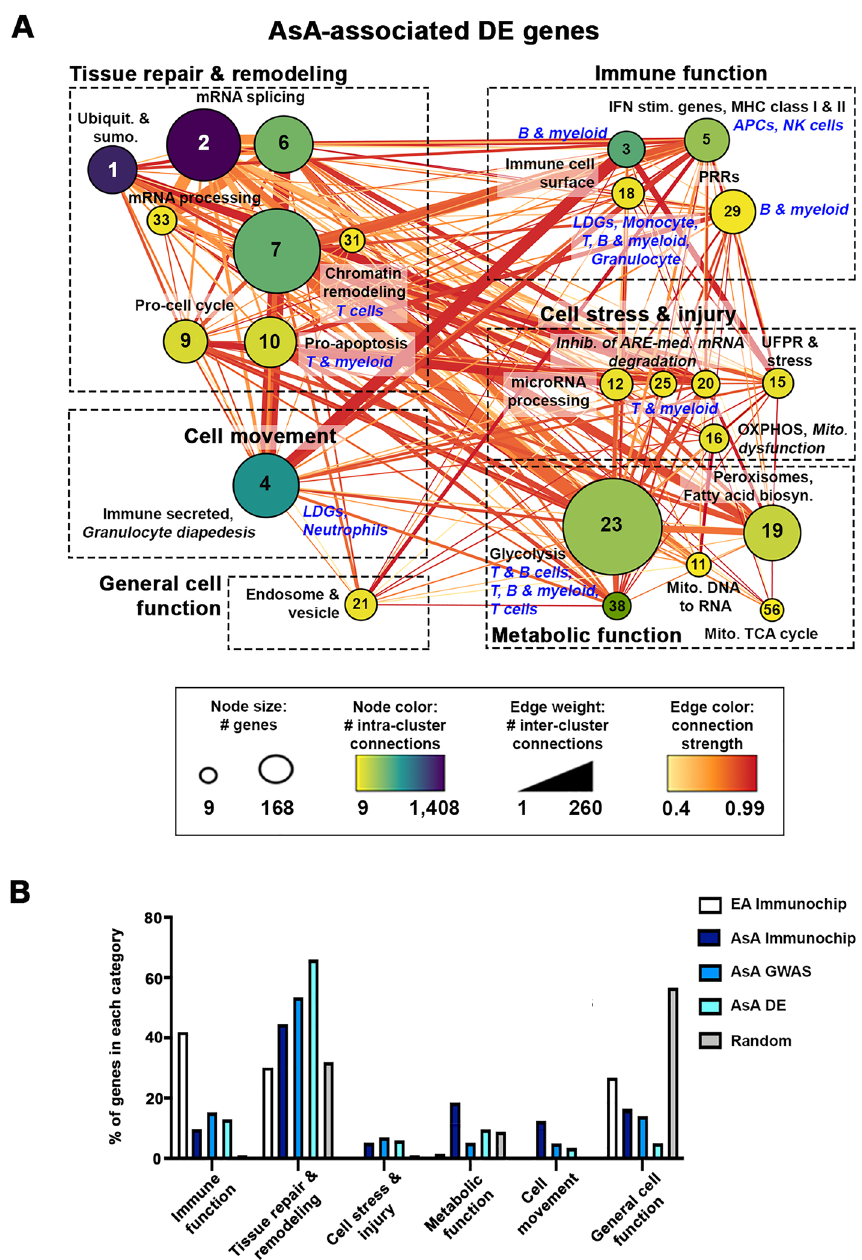
Figure 5. Asian-associated pathways are validated with gene expression data from AsA SLE patients. ( A ) Using differentially expressed (DE) genes from AsA whole blood samples (E-MTAB-11191), metastructures were generated based on PPI networks, clustered using MCODE and visualized in Cytoscape. Cluster size indicates the number of genes per cluster, edge weight indicates the number of inter-cluster connections and color indicates the number of intra-cluster connections. Enrichment for each cluster was determined by BIG-C and IPA; clusters were then grouped and categorized according to overall function (immune, tissue repair, metabolic, motility [Continued from previous page] or genera cell funtionl. ( B ) Bar graph showing the precent of associated (EA/AsA immunochip and AsA GWAS), differentially expressed and random genes falling into each overall functional